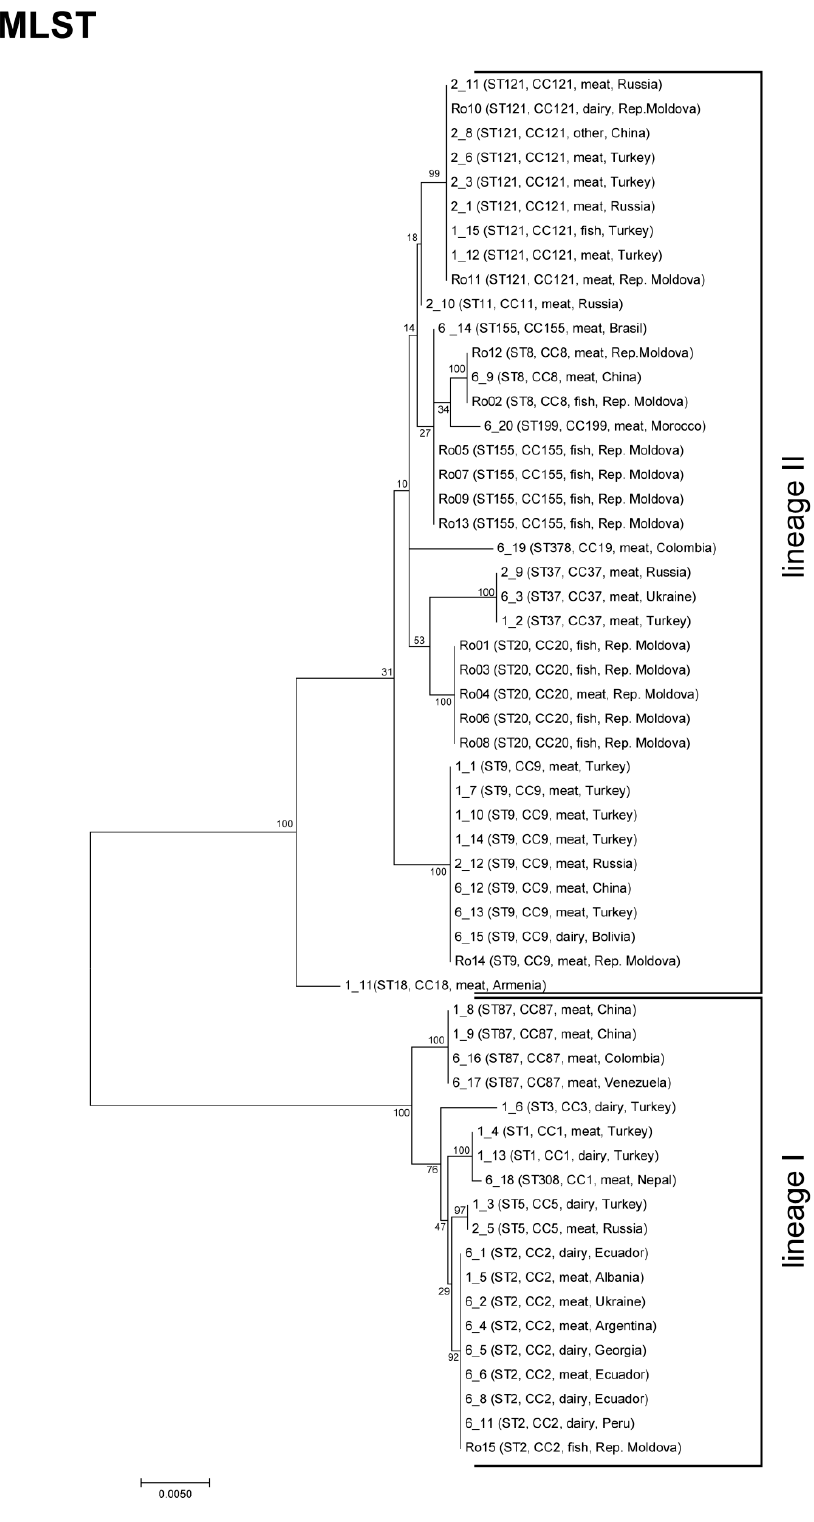
Figure 1. Maximum likelihood phylogenetic tree of Listeria monocytogenes strains based on multilocus sequence typing (MLST) loci. The maximum likelihood phylogenetic tree is based on concatenated full-length MLST gene sequences and was calculated with MEGA7 using the Tamura–Nei model. Bootstrap values (100× resampling) are indicated at the respective nodes. The analysis involved 57 nucleotide sequences. All positions containing gaps were eliminated. There was a total of 3288 positions in the final dataset. The bar represents the number of substitutions per site. L. monocytogenes sequence types (STs), clonal complexes (CCs), source, and the origin country, are indicated.